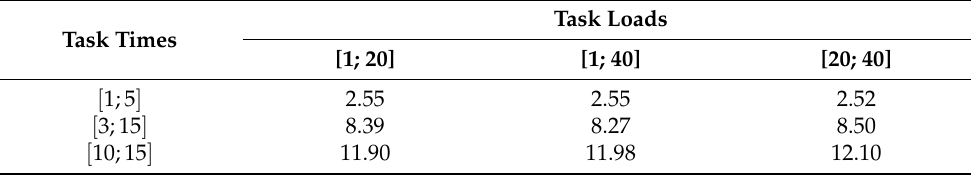
Table 7. Average required time (turns) per task for a given dataset